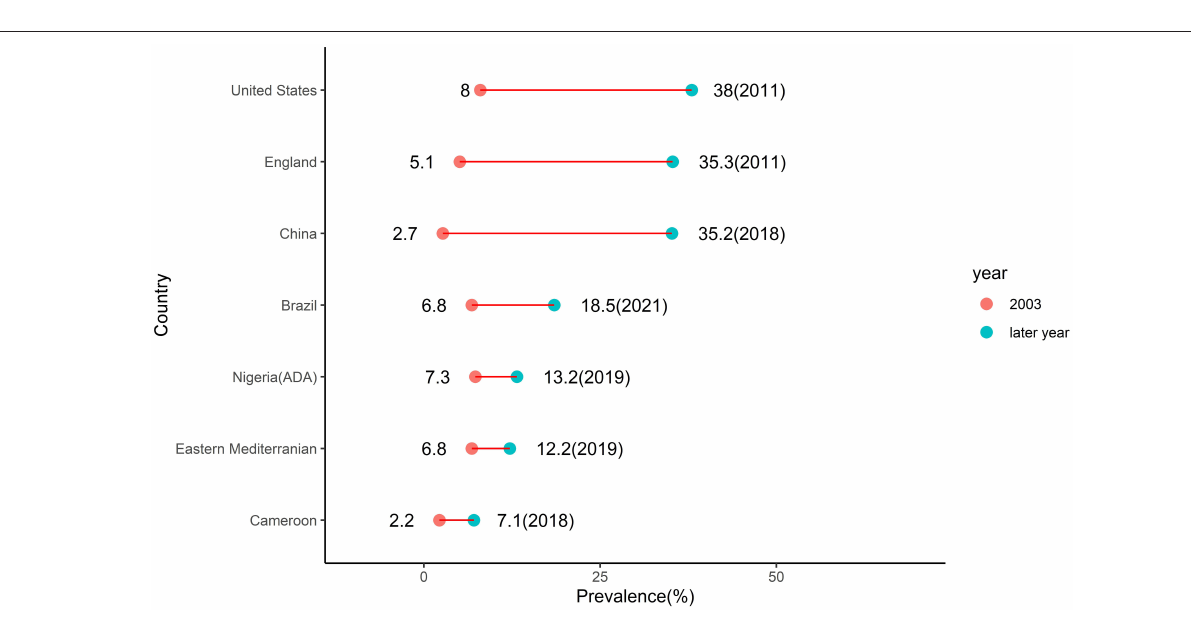
FIGURE 8 | Trends in prediabetes prevalence in selected